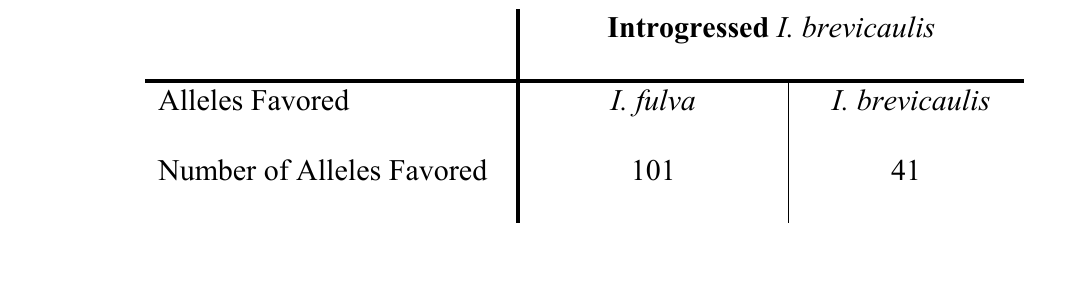
Table 3. The number of I. fulva and I. brevicaulis alleles inferred to be selectively favored in “Introgressed I. brevicaulis ” plants that survived the flooding episode (see Table 2;